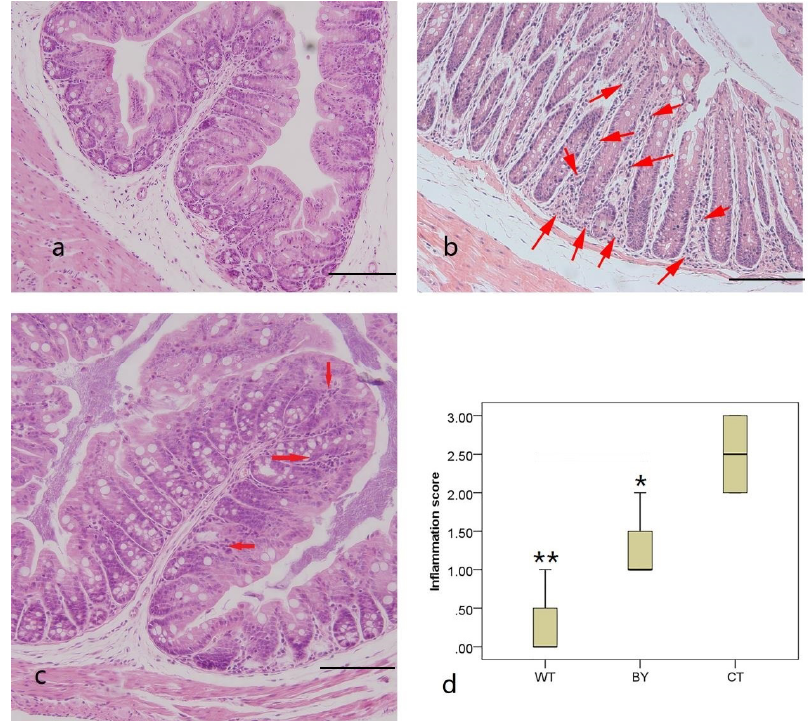
Figure 1. Histological features and scores of the proximal colons from mice in three groups. Representative HE stained sections from three groups ( × 200 magnification) are shown. Wild type mice (WT and ( a )), IL ‐ 10 − / − mice without treatment (CT and ( b )), interleukin (IL) ‐ 10 − / − mice treated with butyrate (BY and ( c )). Arrows indicate infiltration of inflammatory cells. Histological scores of all three groups ( d ). Data are presented as mean ± SEM ( n = 4 for each group, Bars = 100 μ m. * p < 0.05 and ** p < 0.01 versus IL ‐ 10 − / − mice without treatment).